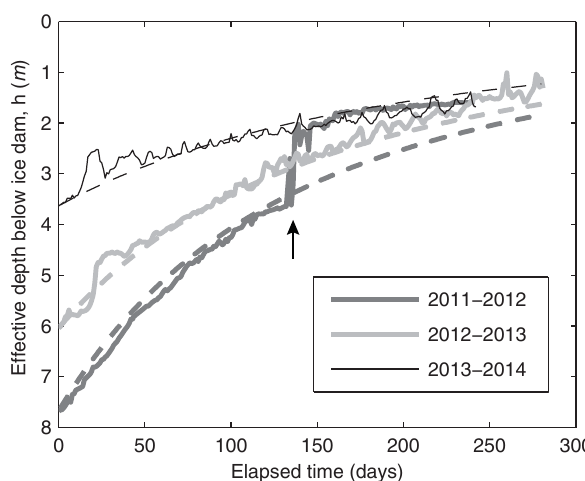
Figure 11. Change in the effective depth ( h ) of the epishelf lake be- low the ice dam over time during the winter of 2011–2012, 2012– 2013, and 2013–2014. Elapsed time is measured from the end of the surface melt season each year. Observed depths (solid lines) are based on the isotherm proxy from the mooring record, while mod- elled depths (dashed lines) are based on a weir equation. Arrow indicates the mixing event that occurred in January